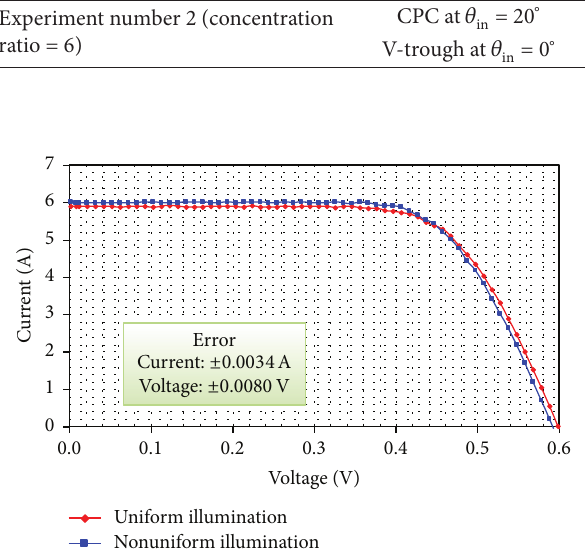
Figure 3: The 𝐼 - 𝑉 characteristics for uniform and nonuniform illumination of a single PV cell at low energy flux concentration ratio. The level of nonuniform illumination was 25% of the total cell area.